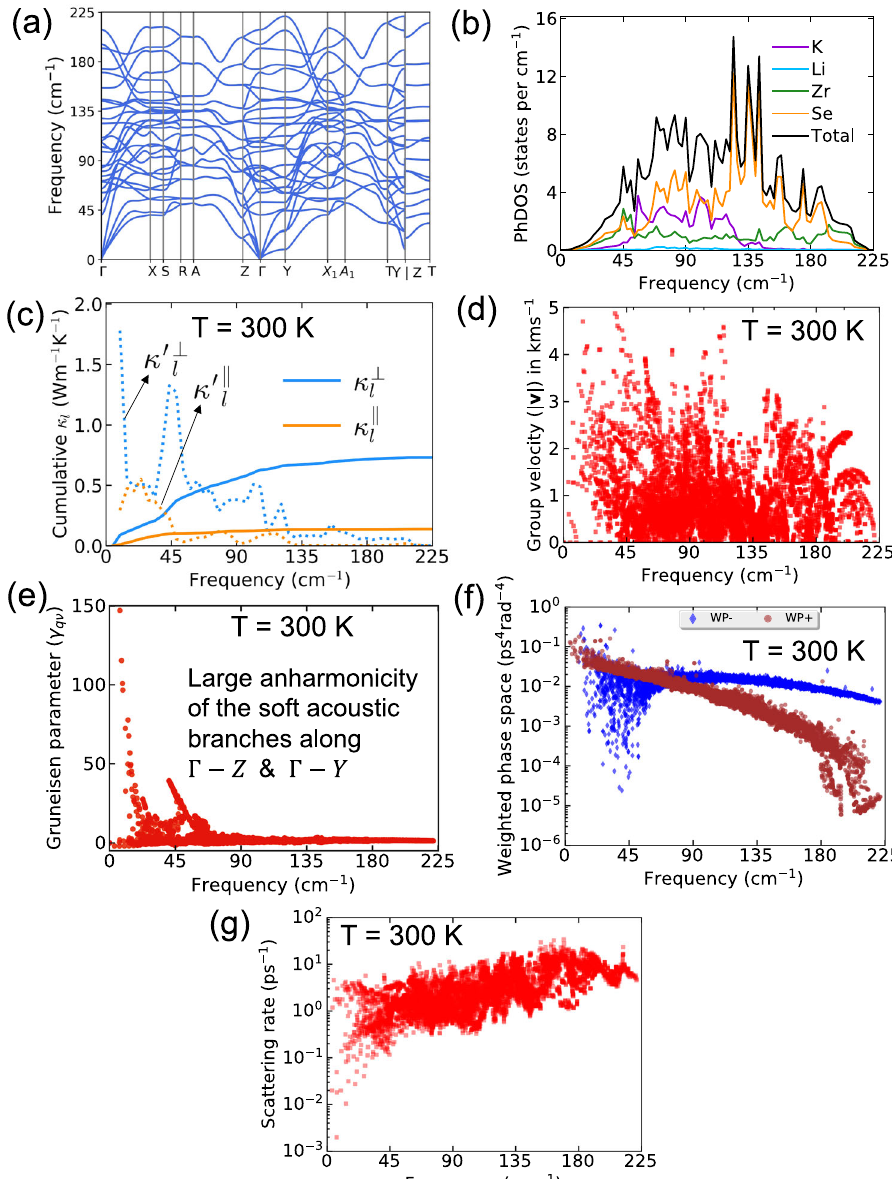
Fig. 6 Harmonic and anharmonic lattice dynamics properties of KLiZrSe 3 . a Harmonic phonon dispersion and ( b ) density of states of KLiZrSe 3 shown up to 225 cm − 1 . c Cumulative lattice thermal-conductivity plots κ ? k , in arbitrary units) with respect to the phonon frequency, which are obtained from the anharmonic lattice-dynamics derivatives ( κ l 0? and κ 0 l calculations. d Group velocities ( v ) of the phonon modes, ( e ) mode Gruneisen parameters ( γ q ν ’ s), ( f ) weighted phase (WP) space of the